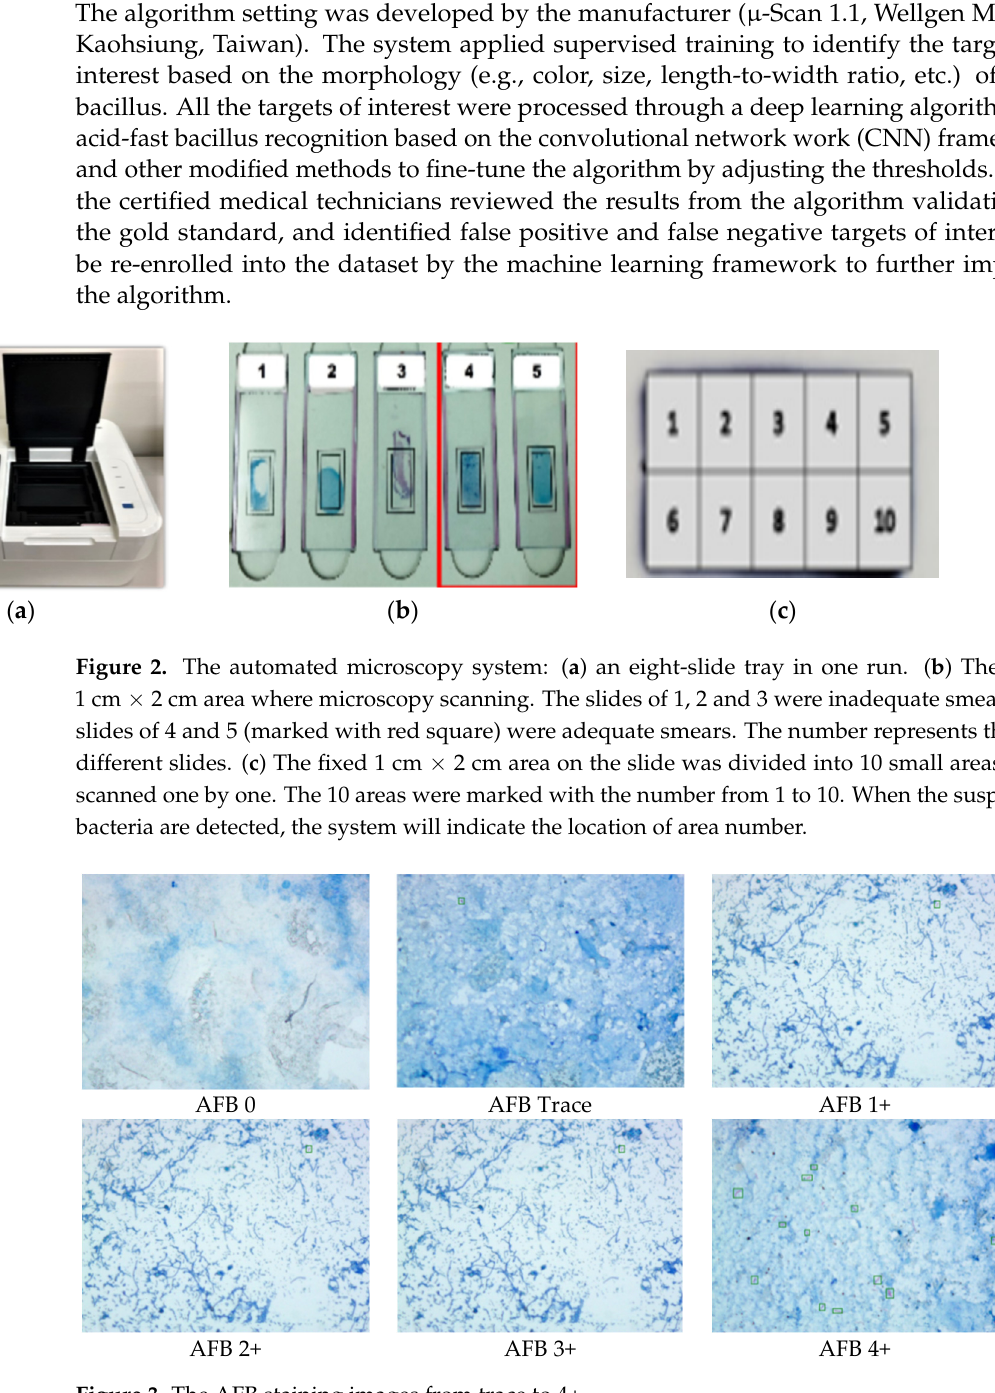
Figure 3. The AFB staining images from trace to 4+.